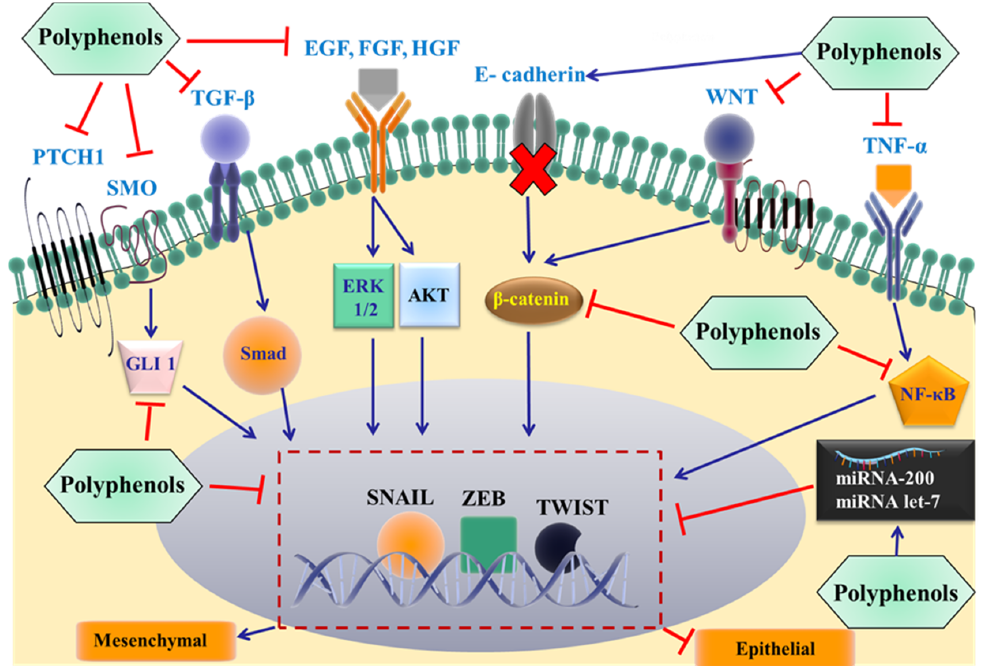
Figure 3. Proposed mechanisms by which dietary polyphenols inhibit EMT and cancer metastasis. The most important extracellular signals are shown, and these promote the epithelial to mesenchymal transition by binding to individual membrane receptors, eventually activating specific EMT-inducing transcription factors (snail, Zeb, and/or twist). The effect of the polyphenols on specific proteins in the signaling pathways at different levels remains to be elucidated. TGF- β : transforming growth factor β ; EGF: epidermal growth factor; HGF: hepatocyte growth factor; FGF: fibroblast growth factor; PTCH1: Patched 1; SMO: smoothened; WNT: glycoprotein family; TNF- α : Tumor necrosis factor- α ; NF- κ B: nuclear factor kappa-light-chain-enhancer of activated B cells; GLI 1: glioma-associated oncogene 1; ERK: extracellular regulated protein kinases; AKT: protein kinase B.